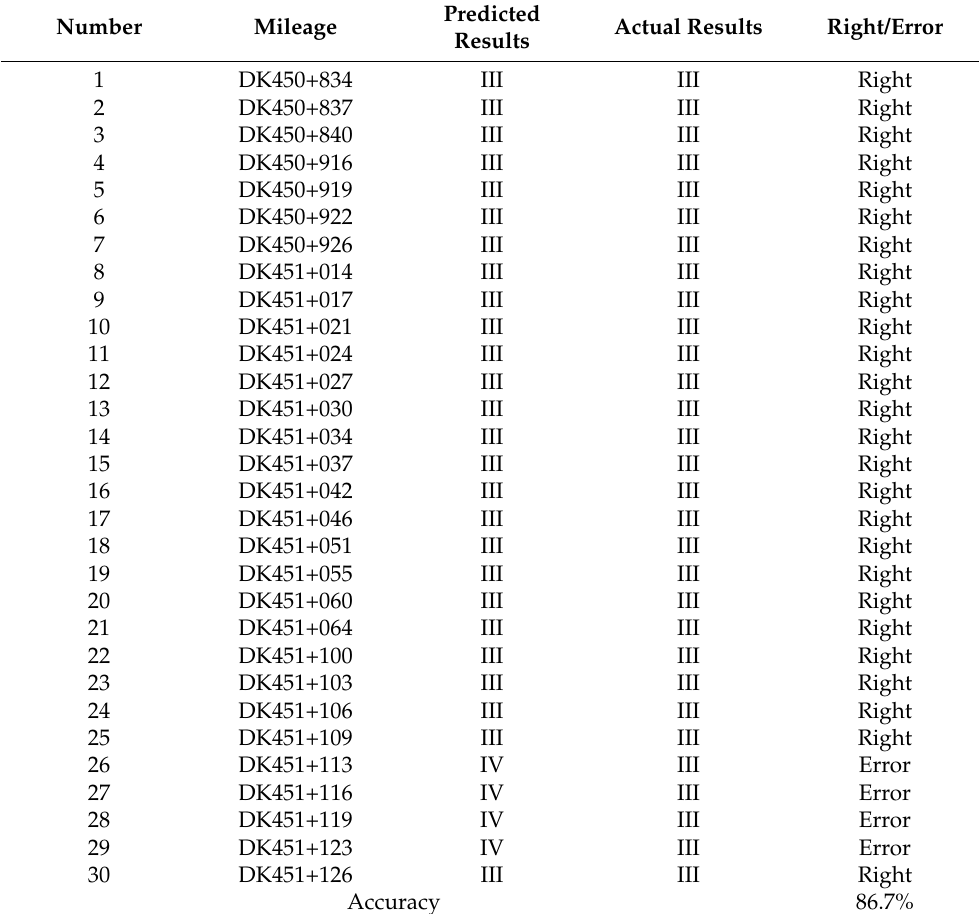
Figure 14. Tunnel face of this test section of the Gaojiaping Tunnel.